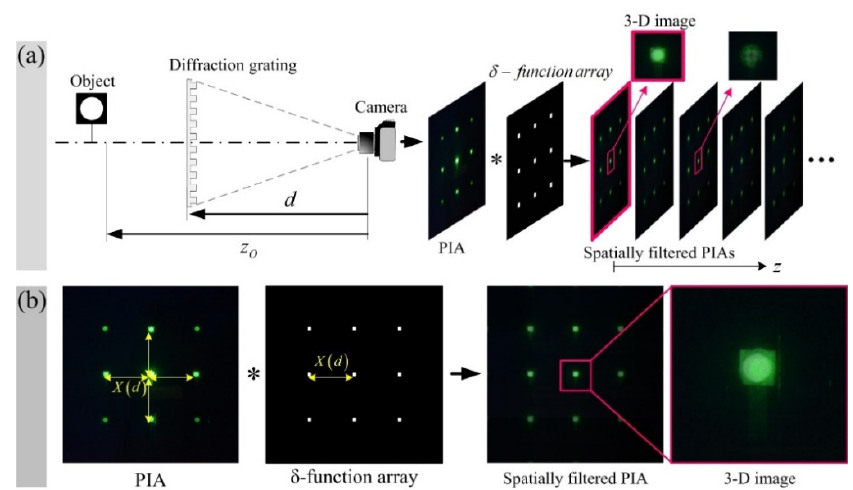
Figure 3. 3-D image reconstruction process with single PIA. ( a ) PIA acquisition process and spatial filtering process. Sequential depth sliced images of the object space are generated through the convolution of the PIA and the δ - function array whose spatial period is continuously changed. ( b ) The spatial filtering result and the 3-D reconstruction image when the parallax image and the δ - function array have the same spatial period.